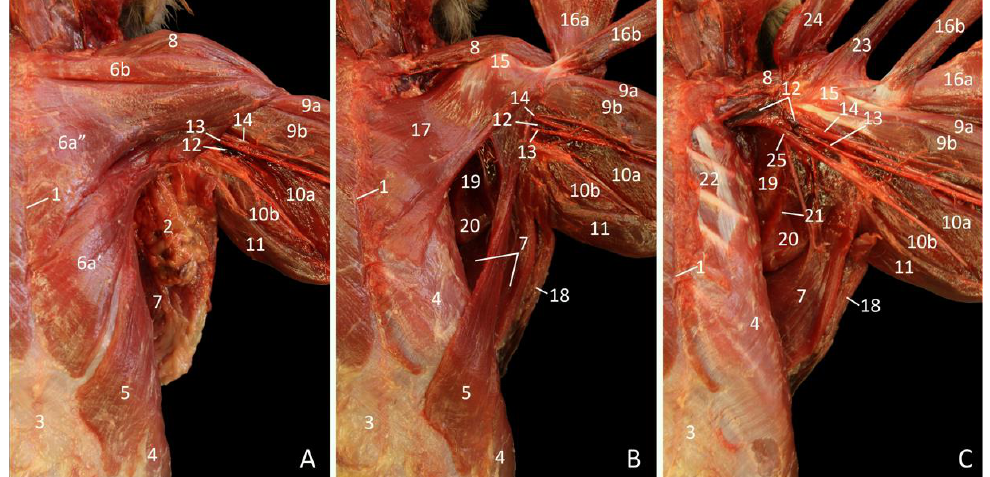
Figure 2. Dorsal view of the junctional musculature between the left thoracic limb and the thorax. The arterial system is filled with red latex. ( A ): Superficial layer; ( B ): Middle layer, after the removal of adi- pose tissue, the lnn. axillares accessorii and the caudal part of the m. pectoralis transversus, and after the cranial part of the de m. pectoralis transversus and the m. pectoralis descendens were